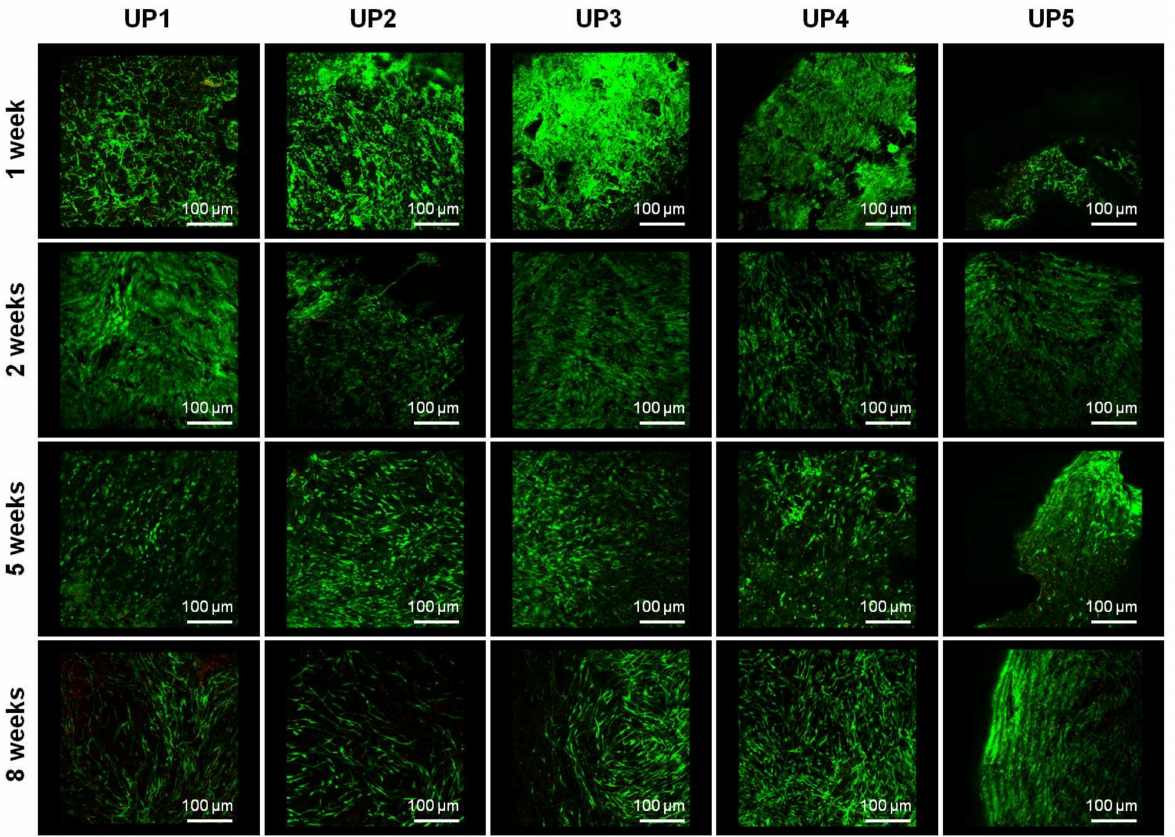
Figure 6. Confocal images of UP scaffolds seeded with human adipose-derived mesenchymal stem cells (hADMSCs), recorded at 4 × magnification. Live/dead staining with calcein AM/ethidium homodimer shows cell viability of hADMSCs after 1 week culture in MSC expansion medium and 2, 5 and 8 weeks culture in osteogenic differentiation medium. For each scaffold, ten serial sections were taken with a step/section set at 50 µ m in the Z direction. In total, an area of 500 µ m in height was analyzed for each scaffold at each time point, so both cell attachment and penetration along the z -axis could be